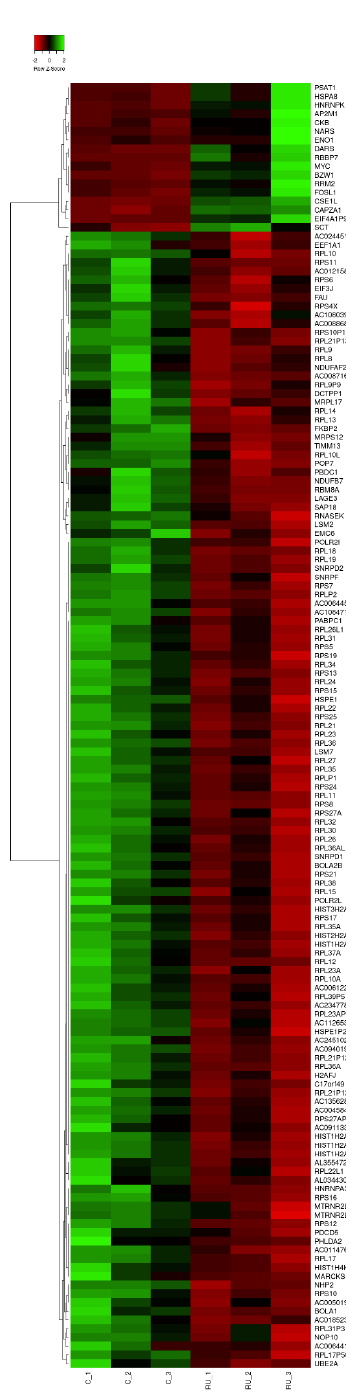
Figure 2. The clustering heatmap indicated the patterns of 147 differential expression genes among the mock and RU-486-treated samples.